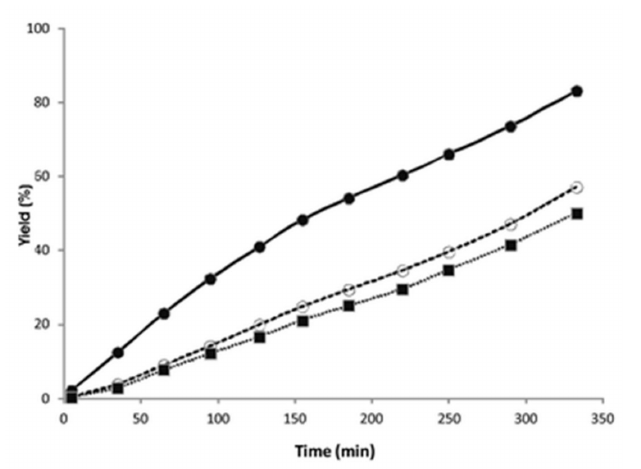
Figure 2. Competitive substrate selective hydration of ethynylcyclohexane ( (cid:8) ), 1-octyne ( and 1-dodecyne ( (cid:4) ) catalyzed by 3@2 in water-saturated benzene- d 6 at 40 ◦ C. (Reproduced from Ref. [21] with permission from The Royal Society of